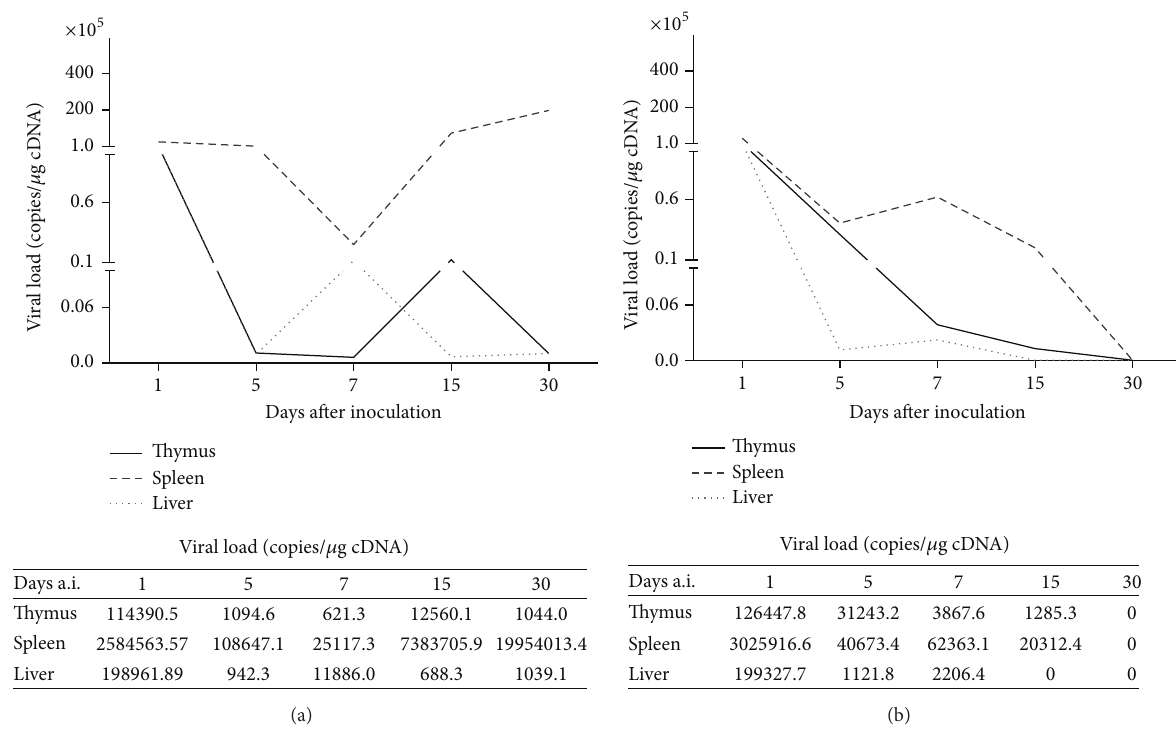
Figure 1: Detection of YFV17D viral load in harvested tissues of (a) C57BL/6 and (b) BALB/c mice. Representative of geometric mean values of viral load (copies/1 𝜇 g cDNA) measured by